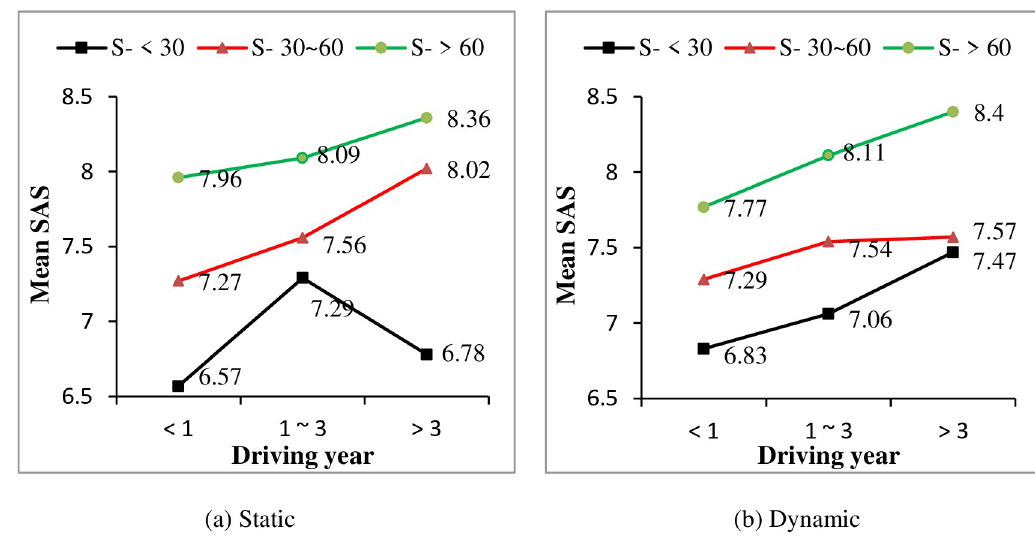
Fig 5. Effect of driving time on self-assessment scores (SAS) under different driving year conditions.